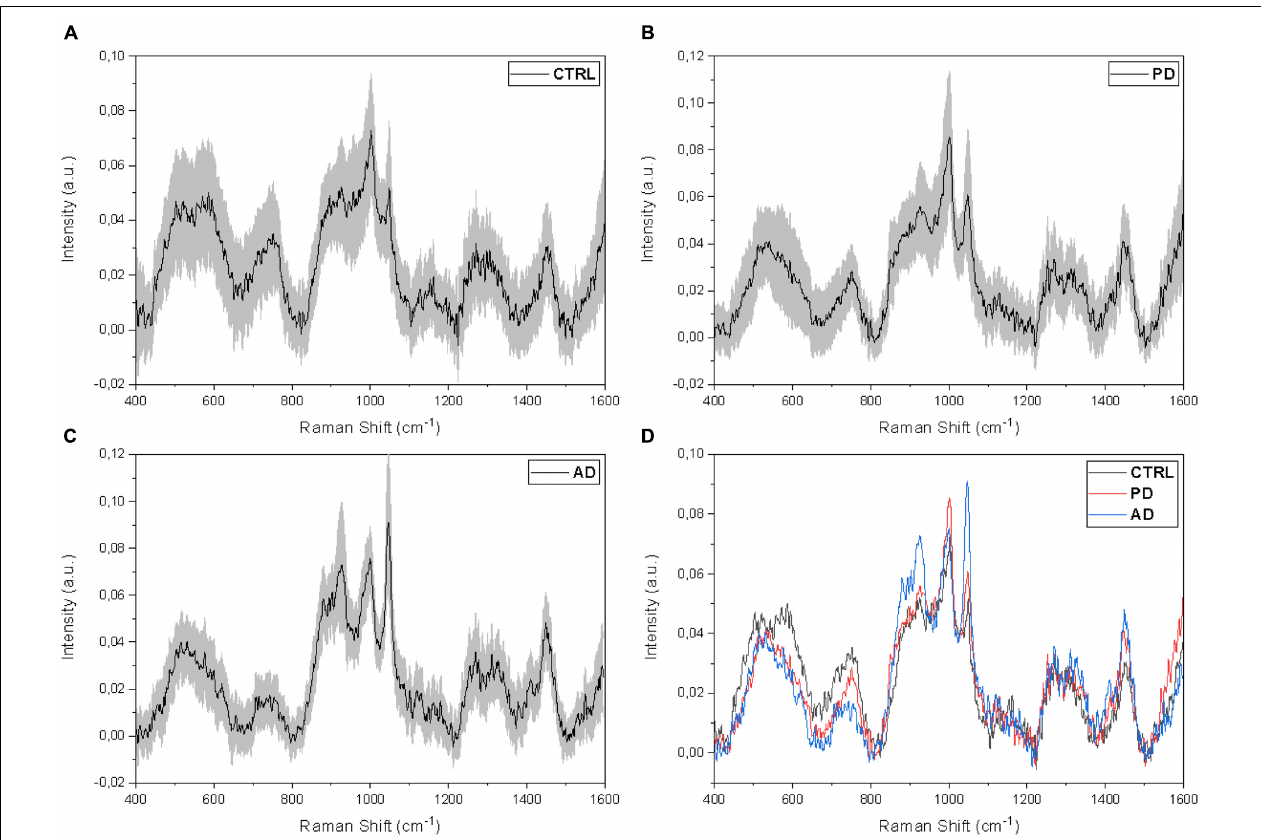
Figure 2 | Average salivary Raman spectra of the (A) CTRL ( n = 33), (B) PD ( n = 23), and (C) AD ( n = 10) experimental groups. The gray bands represent the associated standard deviations. (D) Overlapped average Raman spectra of the three analyzed